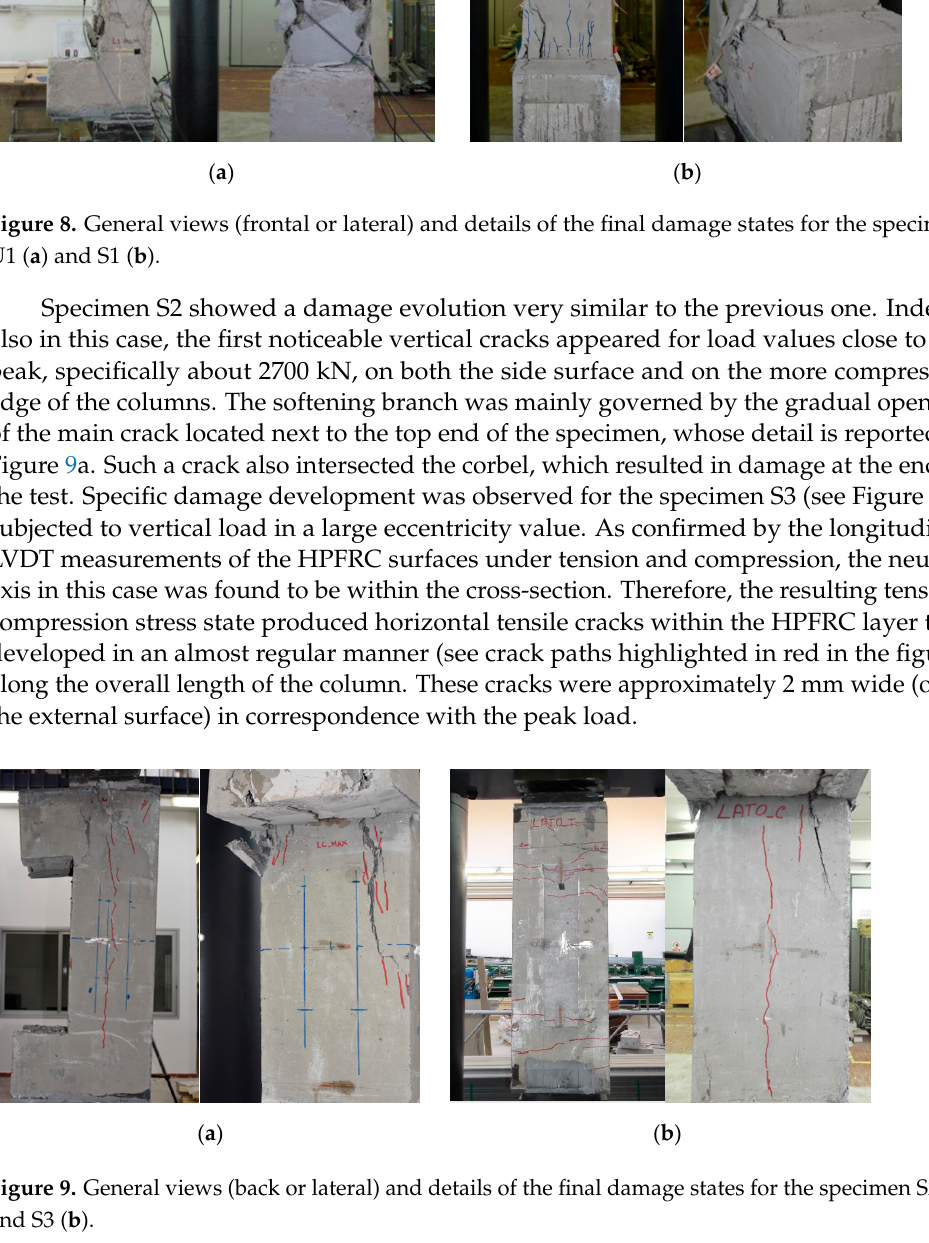
Figure 10. Detailed image of a representative interface piece removed from specimen S2. ( a ) ( b ) Figure 11. Thermographic images of the internal ( a ) and external ( b ) compressed edges of specimen S2.